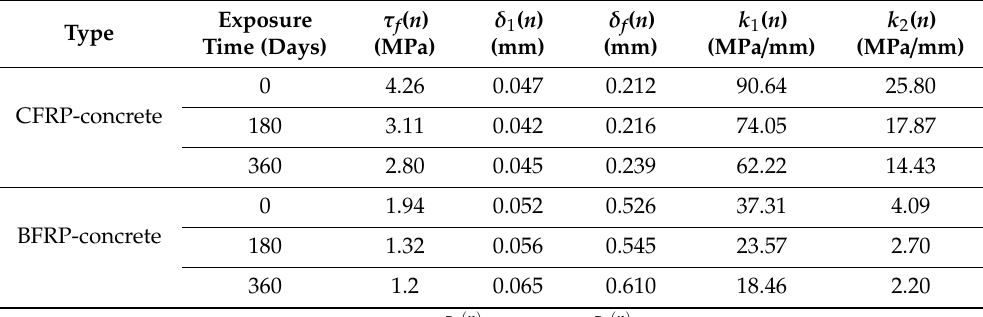
Figure 13. Bond-slip relationships. Table 3. Major bond parameters for stress-slip